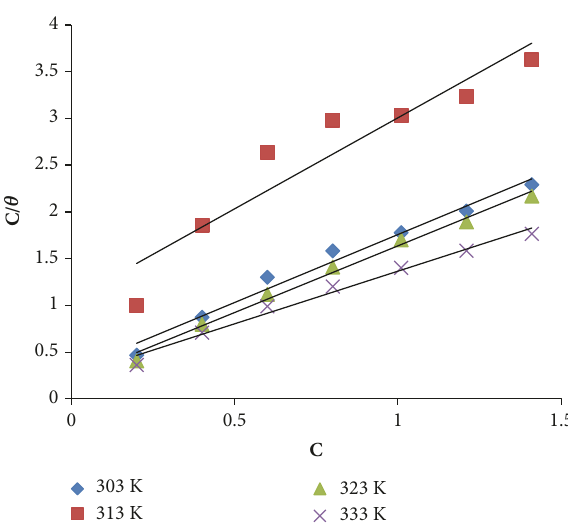
Figure 8: Plot of C/ 𝜃 versus C for various temperature with BFC.